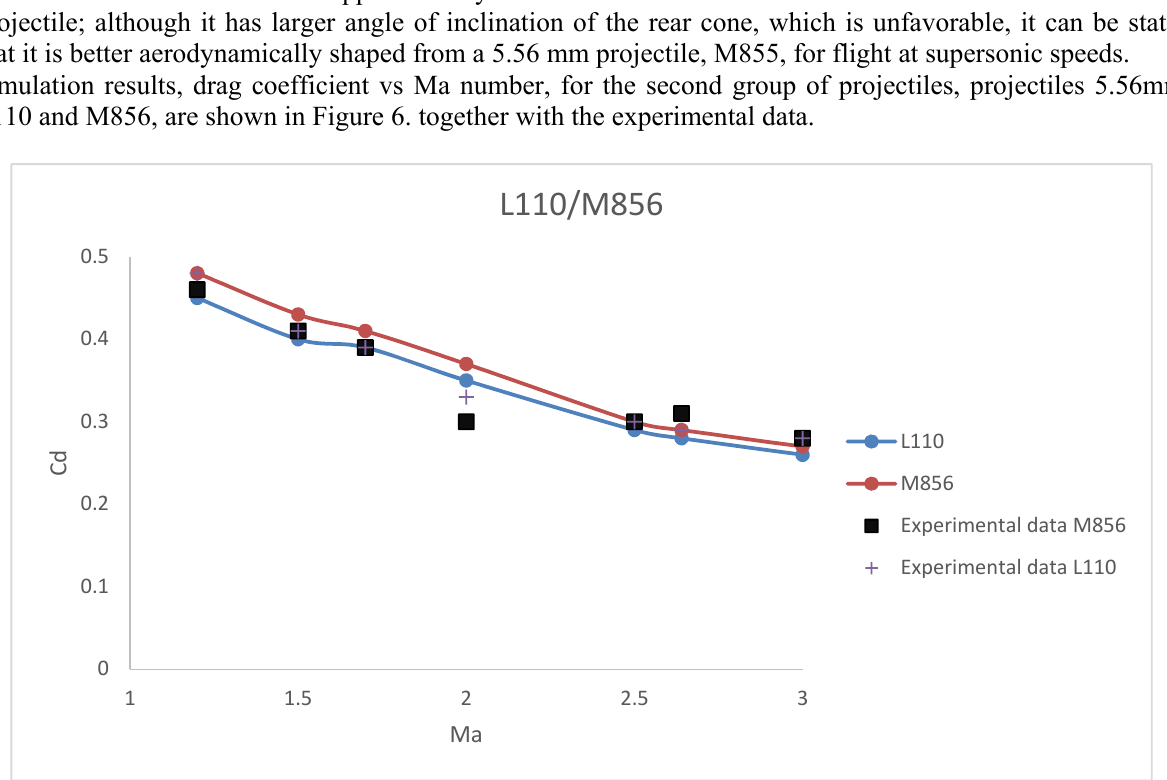
Figure 5. Drag coefficient vs. Mach number for 5.56 mm projectiles, models L110 and M856